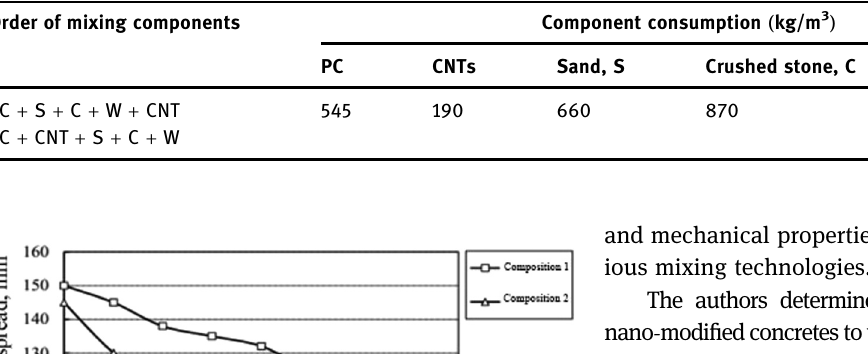
Table 17: Composition and procedure for the preparation of concrete mixtures Order of mixing components